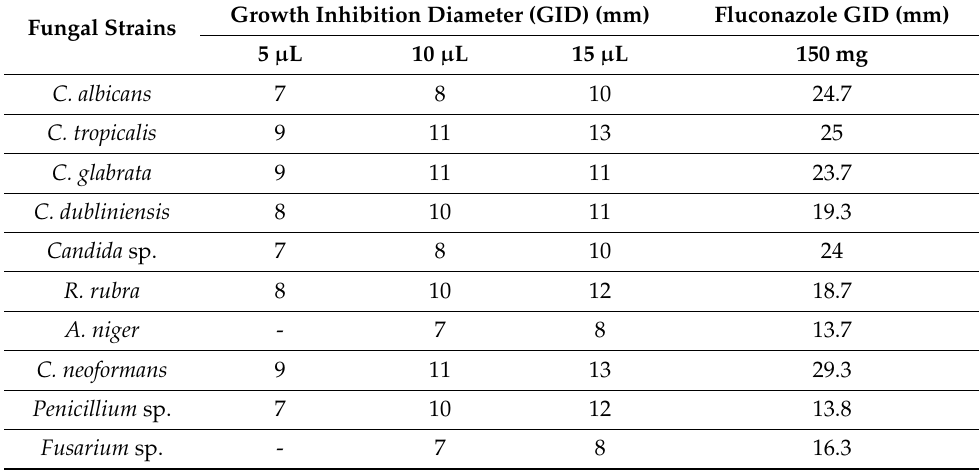
Table 7. The effect of the C. ladanifer essential oil on the MIC and MFC of the selected fungi strains.